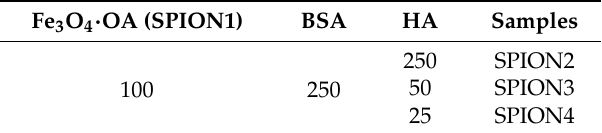
Figure 10. TEM analysis on SPION3: ( A ) low and ( B ) high-magnification bright field micrographs, and ( C ) size distribution histogram of the nanosystems.